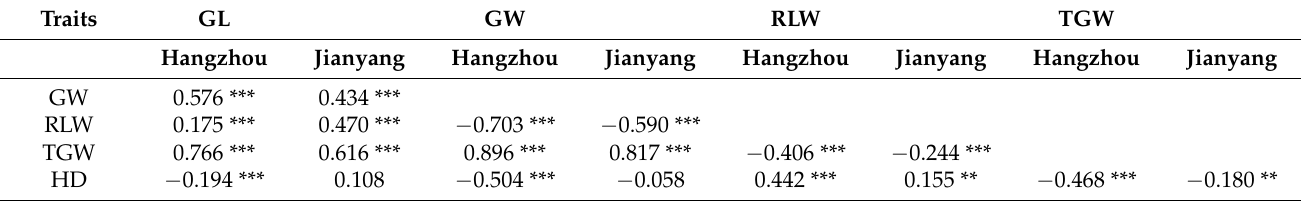
Table 2. Correlation coefficients between five traits in the ZL1 population.